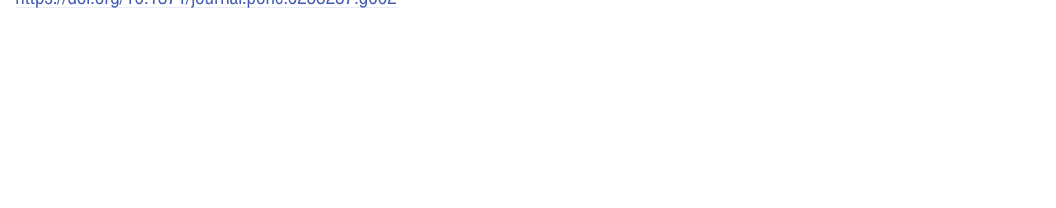
PLOS ONE | https://doi.org/10.1371/journal.pone.0253237 June 21,